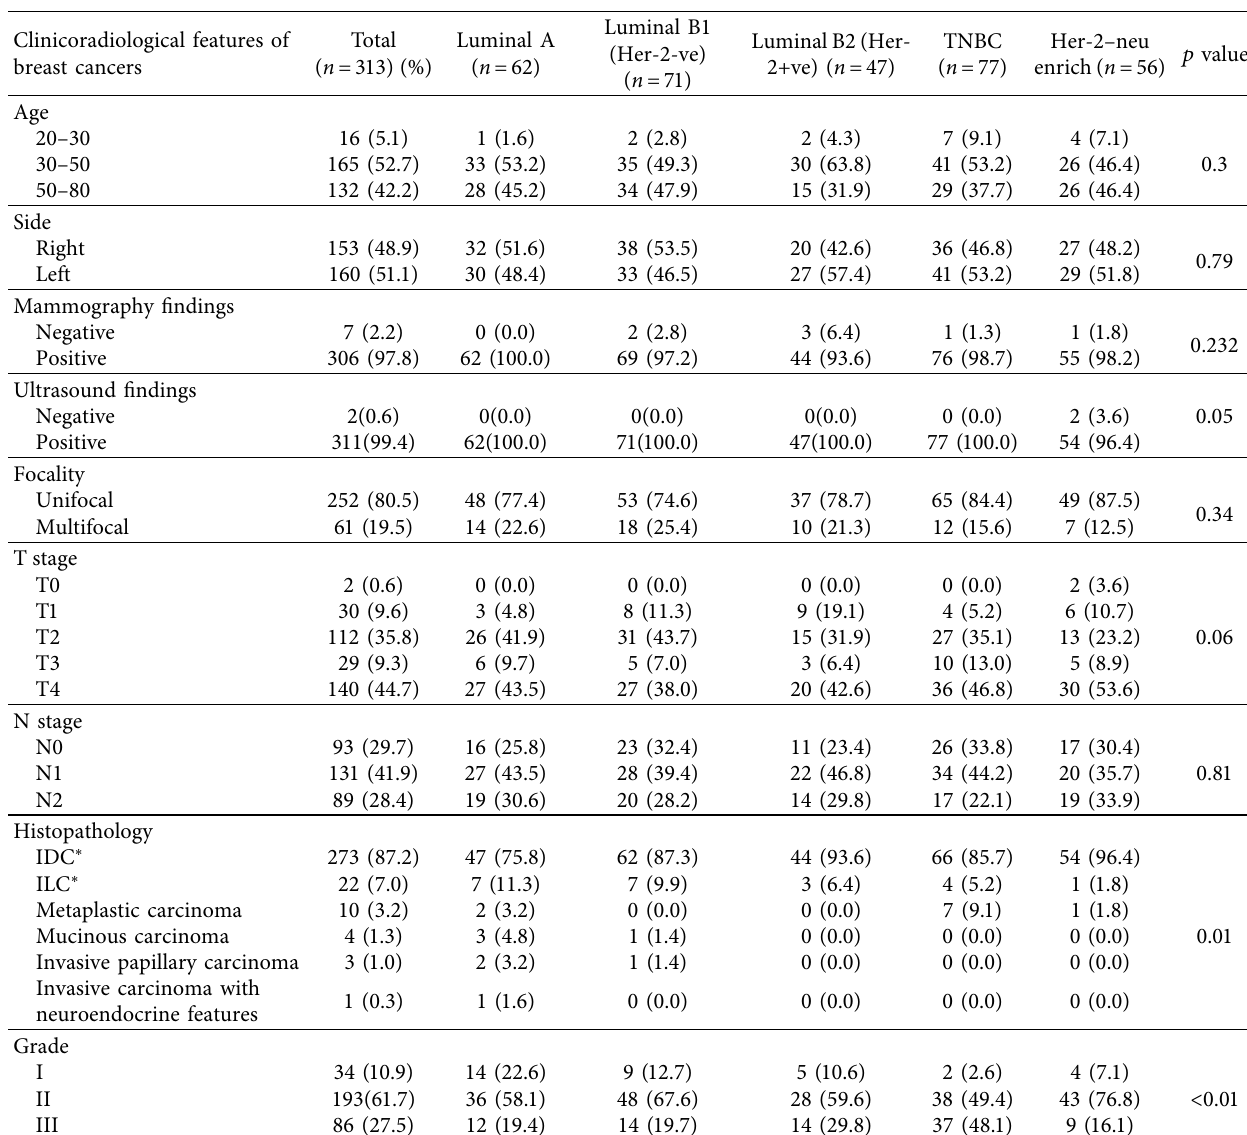
Table 2: Demographic and histopathological